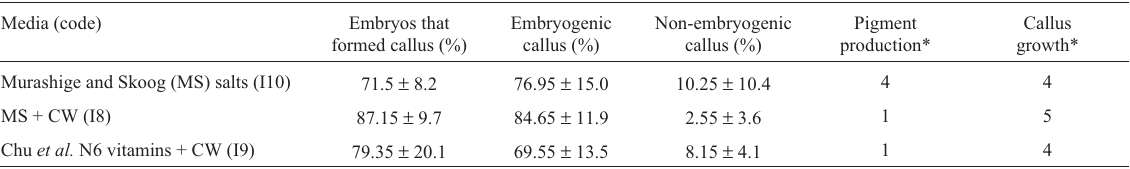
Table 2 - Effect of coconut water (CW) on callus induction from immature embryos of line P898012 evaluated 14 days after plating. Data from an experiment with six petri dishes with 15 embryos in each dish. Media (code) Embryos that